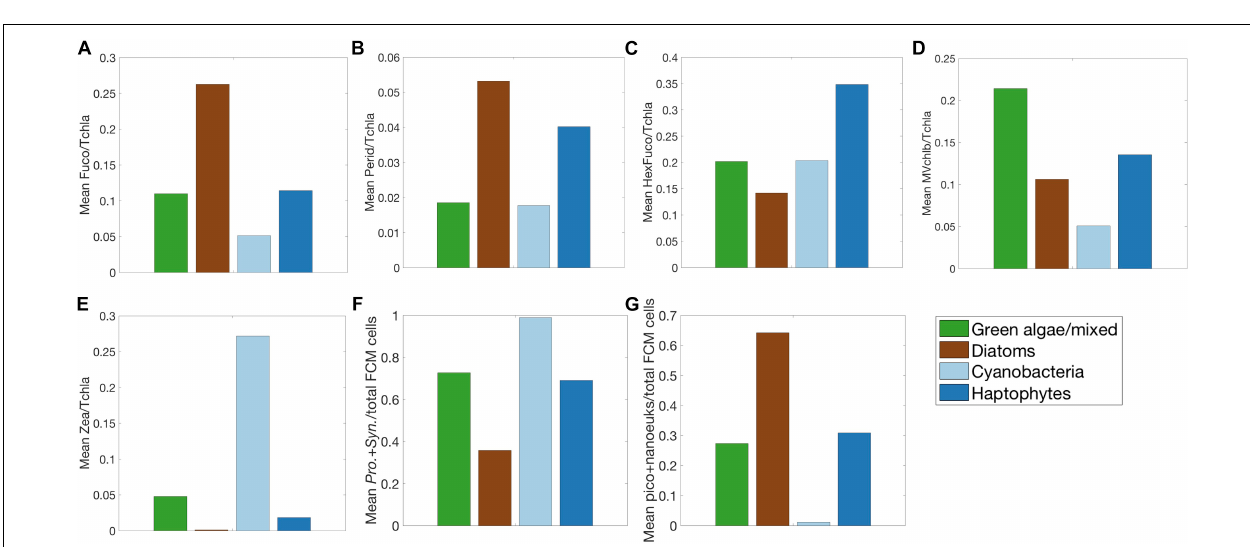
FIGURE 5 | Results of network-based community detection (undirected modularity) for all surface samples. Samples are colored based on the dominant community determined from the community detection analysis: light blue (cyanobacteria), dark blue (haptophytes), green (green algae), brown (diatoms and dinoflagellates). Latitude plotted in gray.